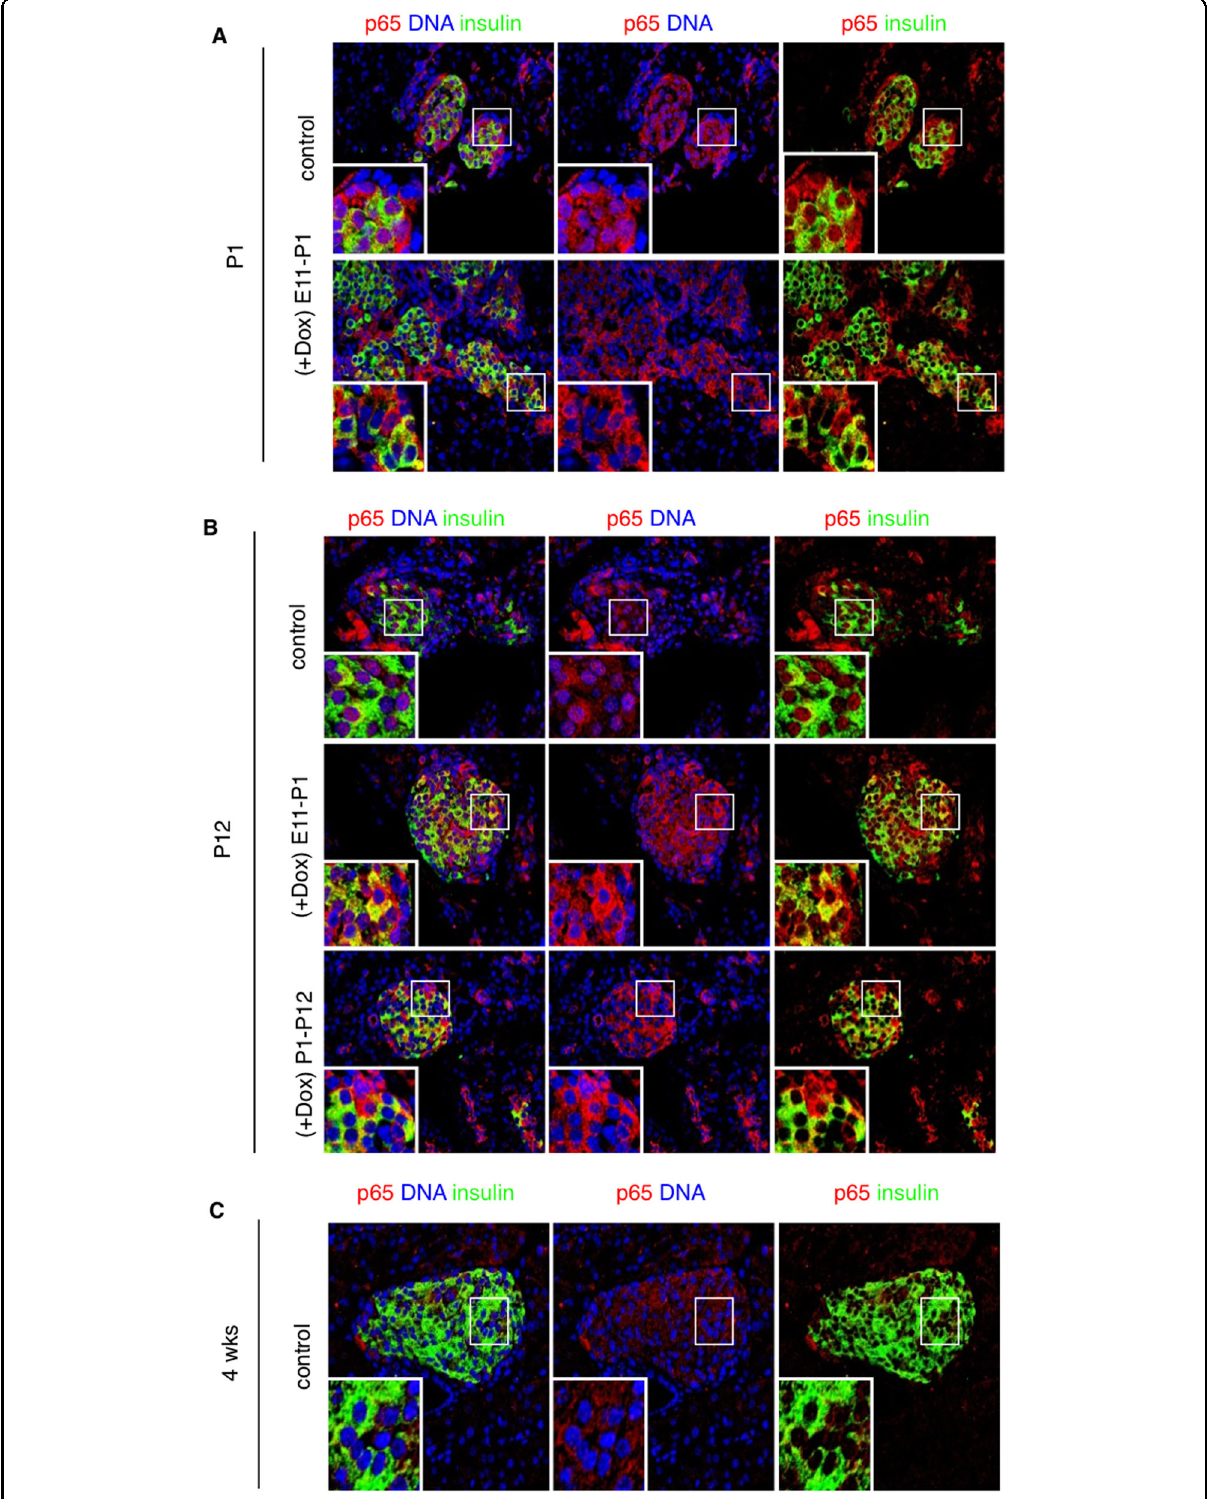
Fig. 2 Physiological localization of the NF- κ B p65-subunit in the pancreas of (A) newborn (P1), (B) neonate (P12), and (C) young adult (4 weeks) in parental ToI β mice. Pancreata of untreated original ToI β (control) or Dox-treated during the embryonic period (E11 – P1) or for 3 weeks after birth (P1 – P21) were immunostained for p65 (red), insulin (green), and DNA (blue). Pictures are representative confocal images of islets from three to fi ve different mice per group. For each mouse, ~15 – 20 islets were analyzed. Original images were taken at a magni fi cation of ×40. Inset images were digitally increased